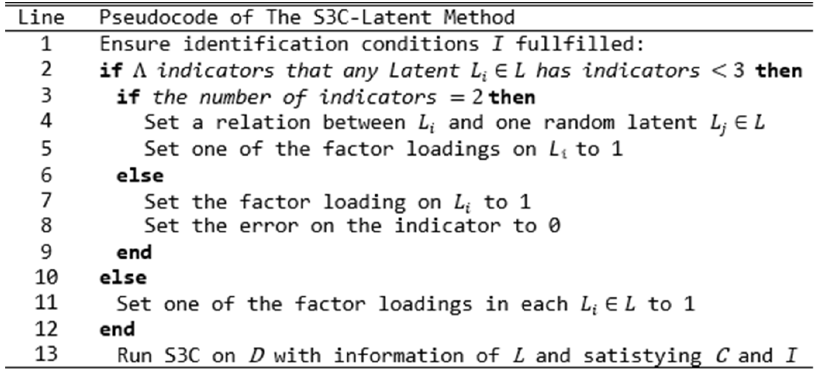
Algorithm 2. The Pseudocode of S3C-Latent